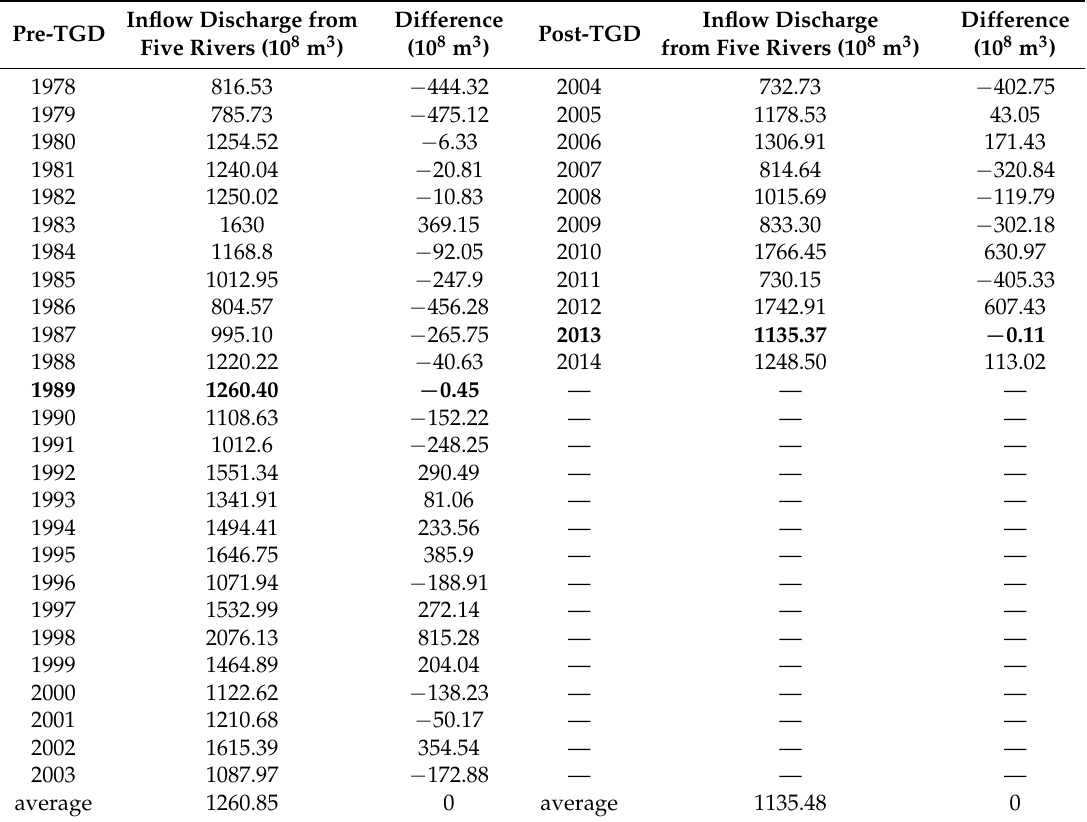
Table 2. The comparisons of total annual runoff with average annual runoff for the pre-Three Gorges Dam (TGD) and post-TGD